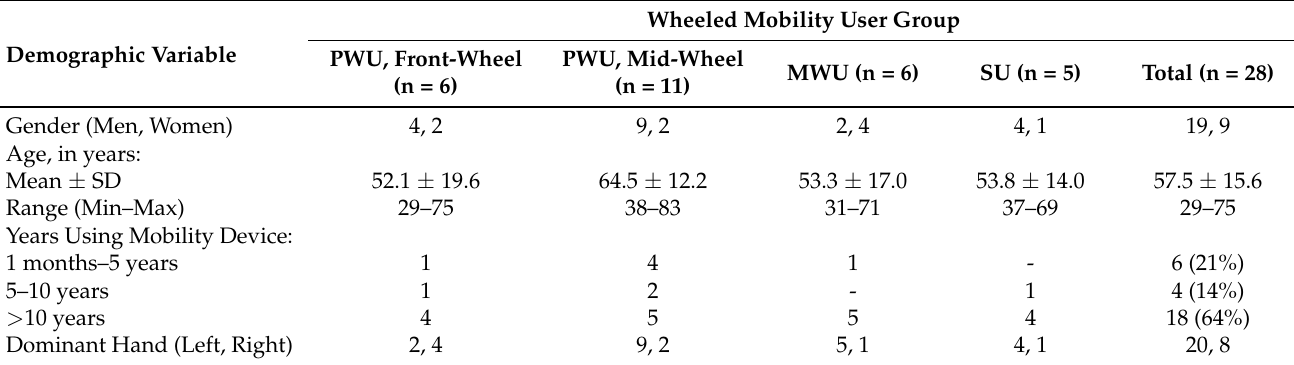
Table 1. Demographic information of the study sample (n = 28) stratified by type of wheeled mobility device used. PWU = Powered Wheelchair Users, MWU = Manual Wheelchair Users, SU = Scooter Users.